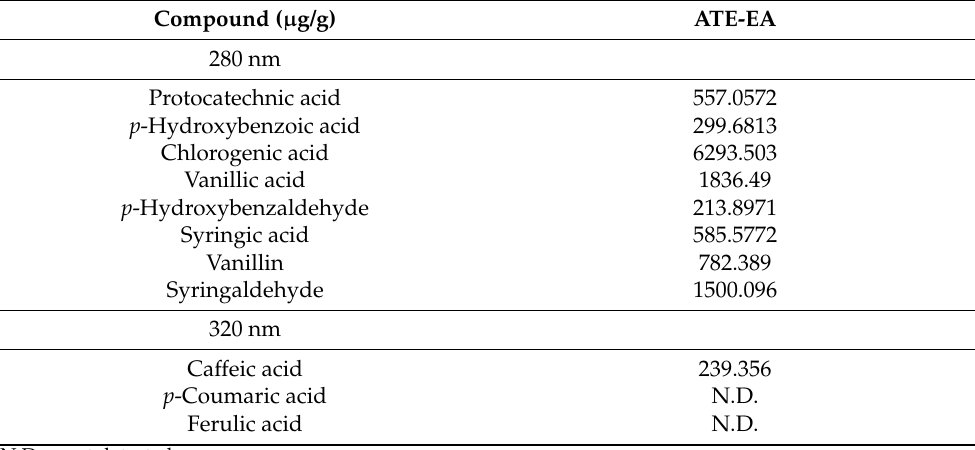
Table 1. Detection and quantification of the phenolic compounds from ATE-EA by HPLC.